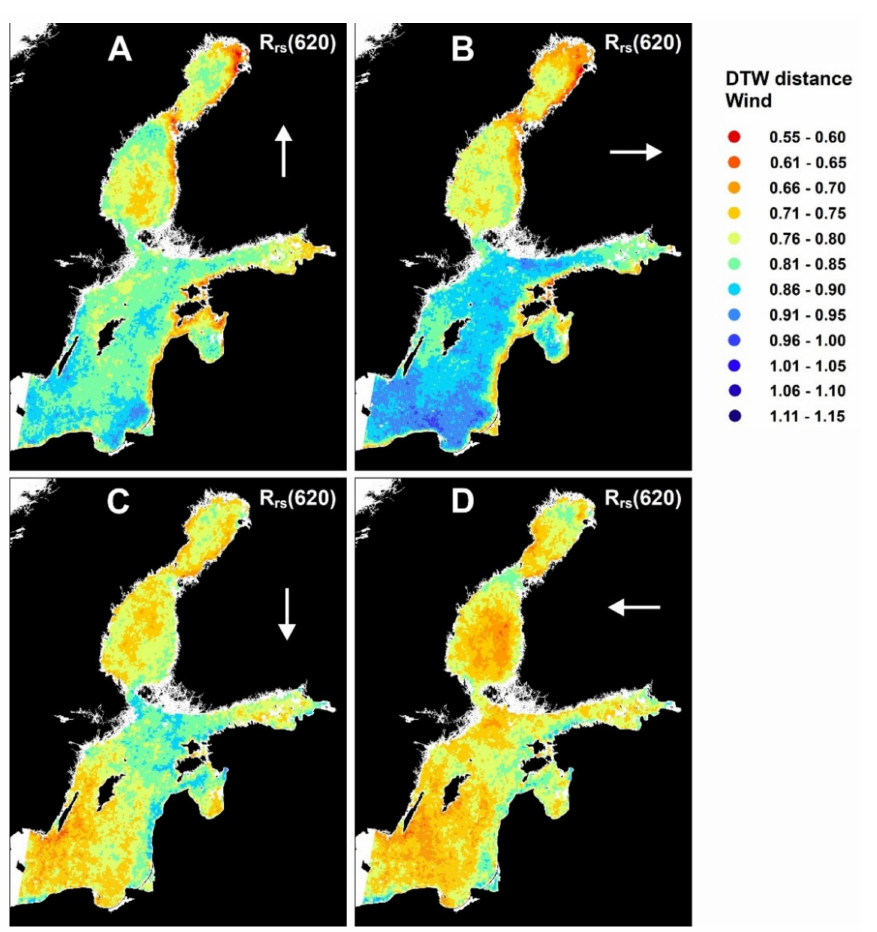
Figure 12. Time series distances from (standardized) wind components to R z (620). In reddish areas stronger winds were more closely followed by elevated reflectance than in blueish areas. ( A ) north wind, ( B ) east wind, ( C ) south wind, ( D ) west wind.